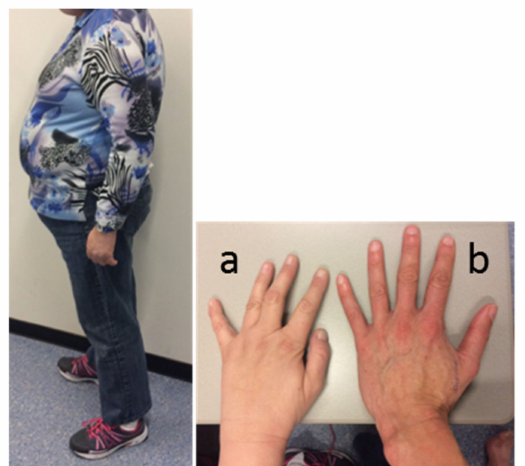
Figure 1. Appearance of the index case. Picture of the patient’s body, and left hand ( a ) compared to the hand of a healthy female control ( b